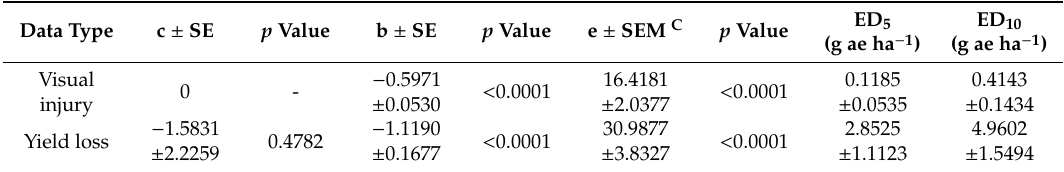
Table 8. Parameter estimates for non-linear regression A,B .